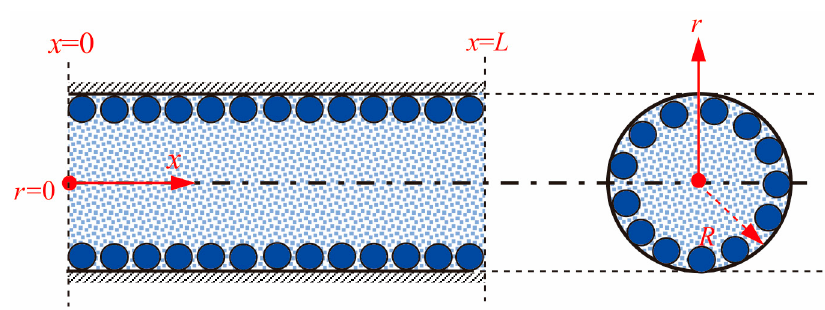
Figure 2. Schematic of fluid flow in circular capillary.